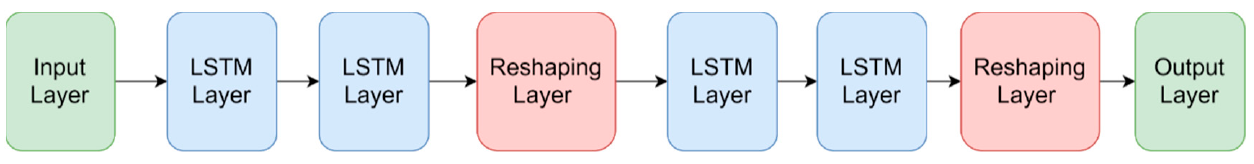
Figure 3. Illustration of the autoencoder model.